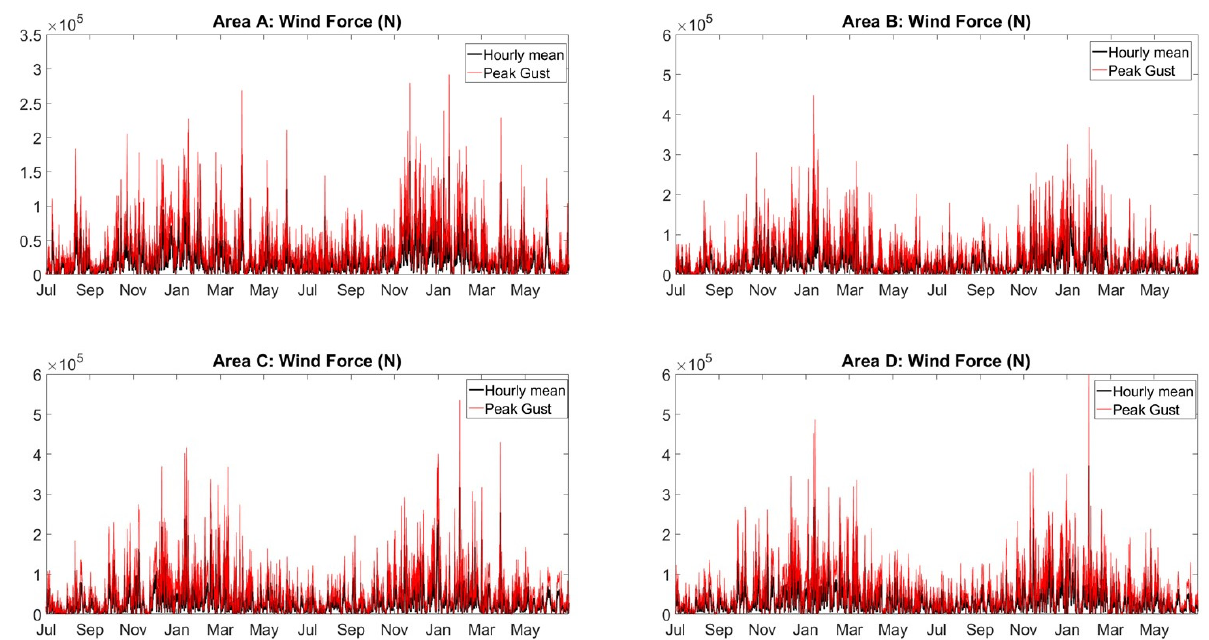
Figure 14. Hourly time series of area-averaged wind drag force (N) in areas A, B, C, and D from July 2014 to June 2016, and for pile diameter 𝐷 = 5 m and height of 100 m. Hourly mean wind speed (black) and peak gust over 3 sec (red) are depicted.